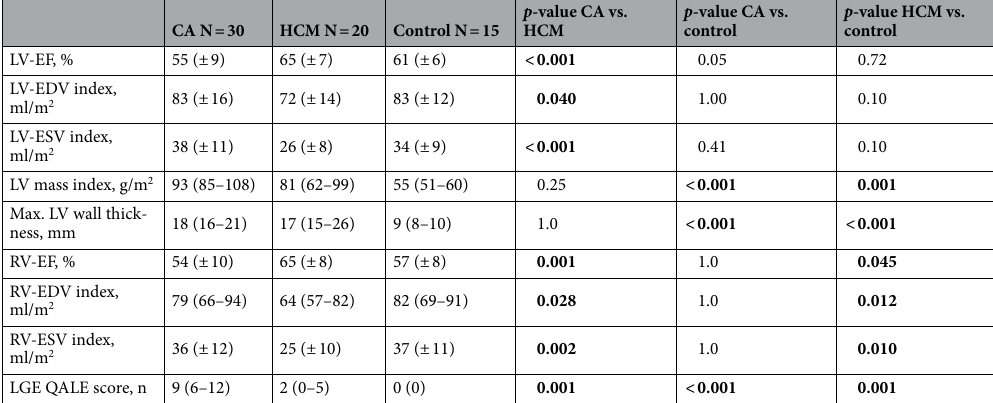
Table 2. Conventional CMR results. Bold values indicate significant p -value < 0.05.